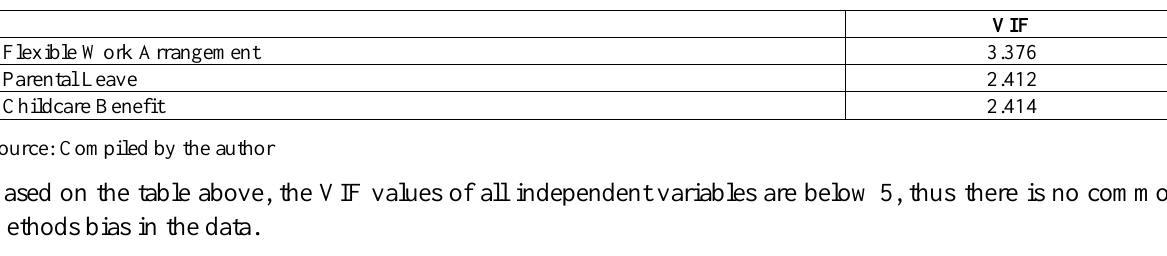
Table 3. Independent Variable VIF Values